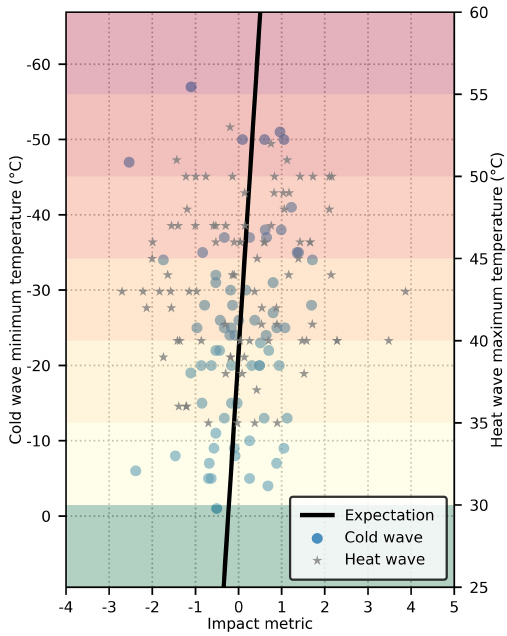
Figure 6. Cold wave minimum temperature versus heat wave max- imum temperature.